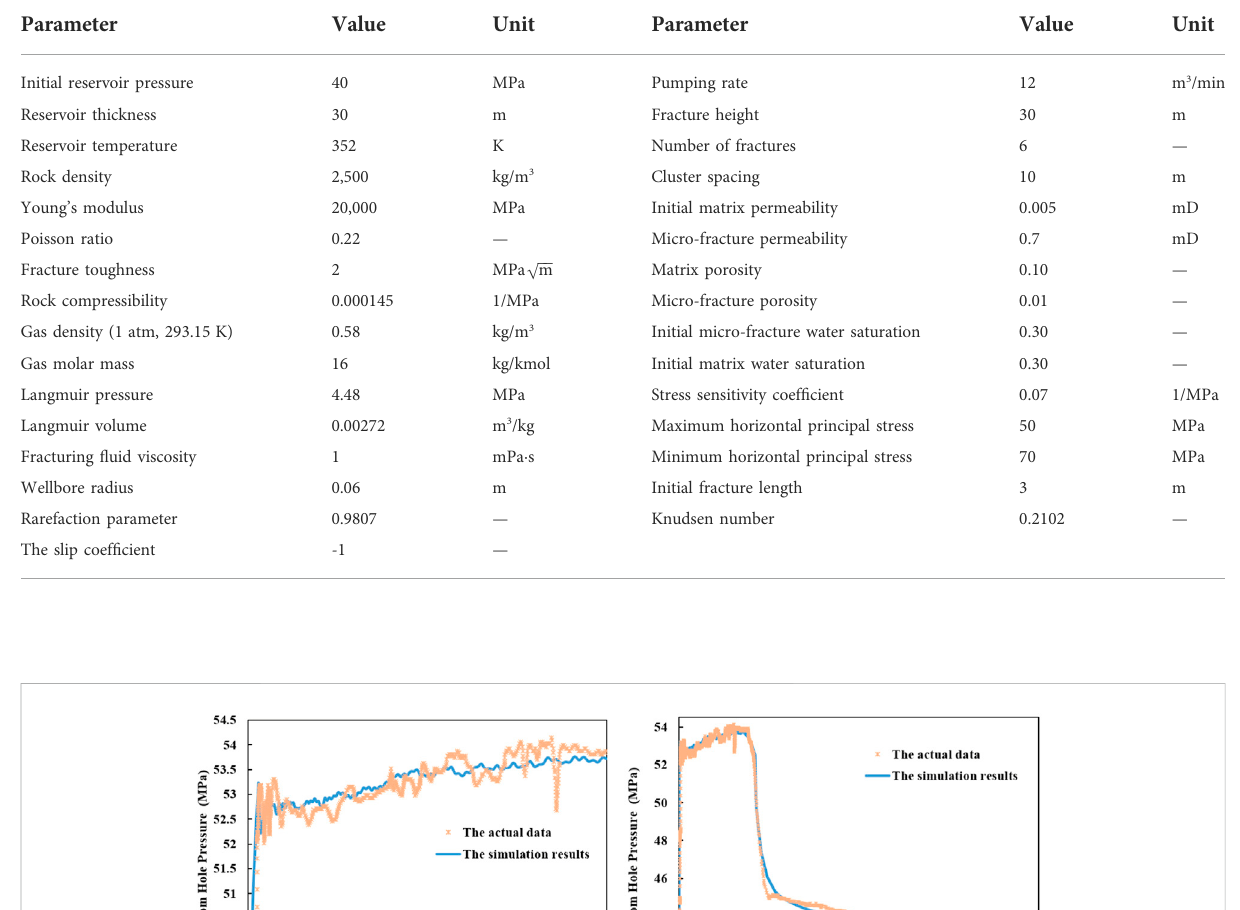
TABLE 1 Basic parameters used for the